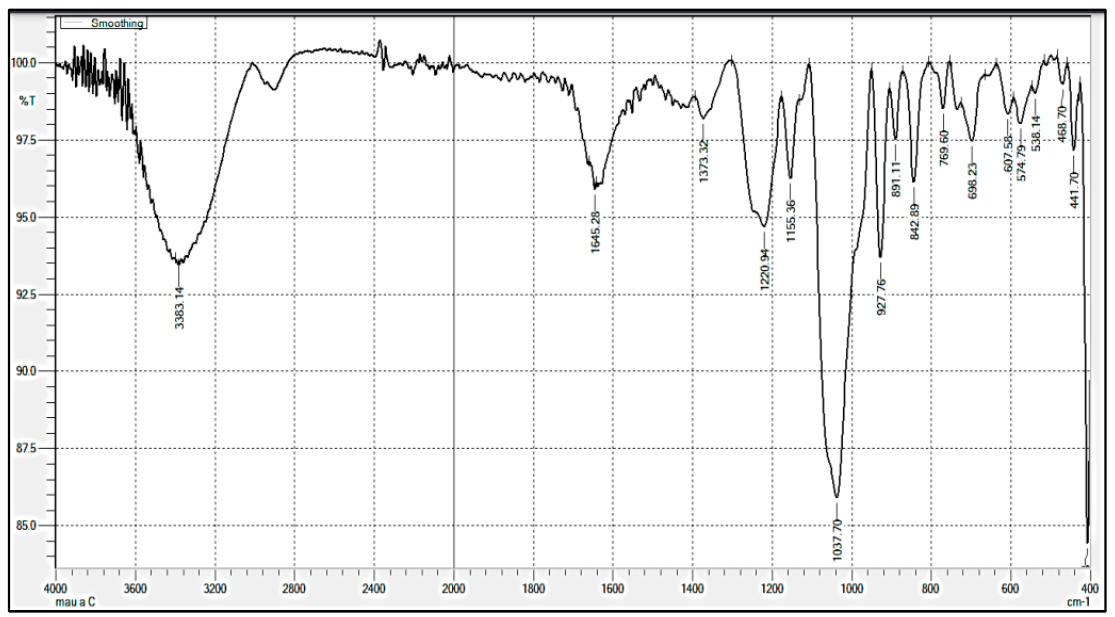
Figure 4. FTIR spectroscopy of antioxidant carrageenan.